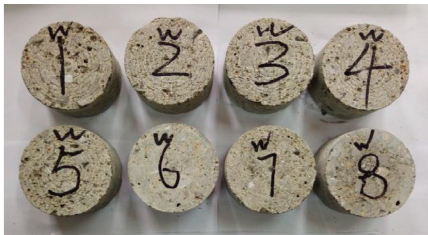
Figure 1: Ready-mixed concrete